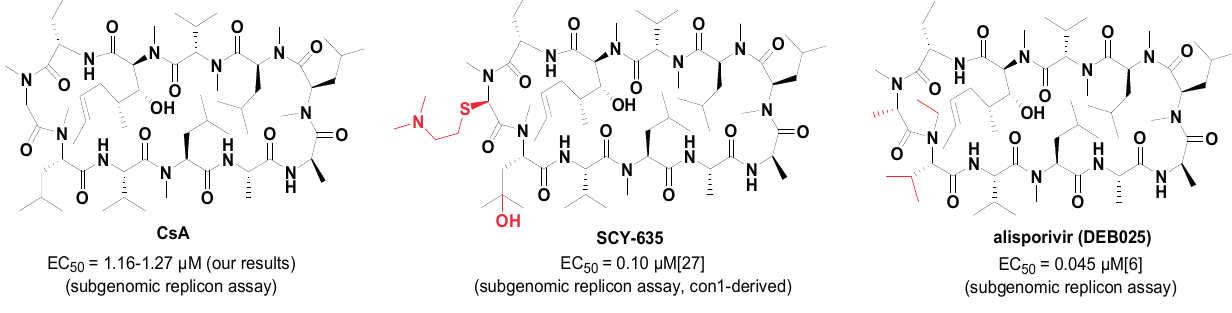
Figure 1. Chemical structures and anti-HCV activities of CsA, SCY-635 and